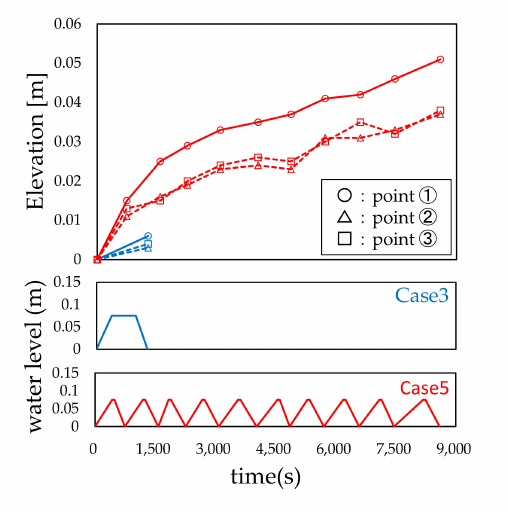
Figure 8. Local scour depth of Cases 3 and 5.